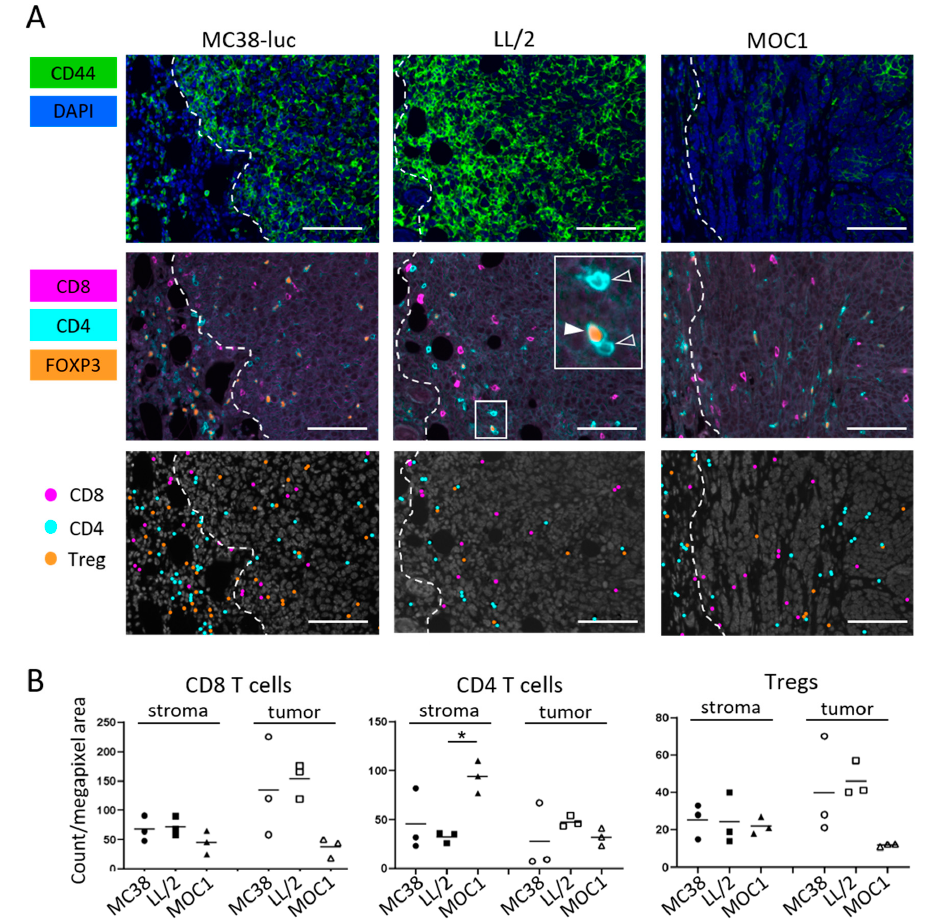
Figure 2. CD44 expression and immune cell infiltration within MC38-luc, LL / 2, and MOC1 tumors. ( A ) Multiplex immunohistochemistry (IHC) staining was performed to examine CD44 expression and distribution of T cells within MC38-luc, LL / 2, and MOC1 tumors before treatment. The top panels show CD44 expression (shown in green). Nucleus were stained with DAPI (shown in blue). White dotted lines represent tumor edges. The middle panels show expressions of CD8 (magenta), CD4 (cyan) and FOXP3 (orange). Inset shows examples of non-regulatory CD4 T cells (membrane CD4 + /nucleus FOXP3 - , open arrowhead) and Treg (membrane CD4 + /nucleus FOXP3 + , filled arrowhead). The bottom panels show cellular phenotypes based on the antigen expressions. CD8 T cell, non-regulatory CD4 T cells, Tregs are shown as dots in magenta, cyan and orange respectively. Representative images from at least three samples are shown (×200, scale bar = 100 µm). ( B ) T cell count in the tumor microenvironment. Cell number of CD8 T cells, non-regulatory CD4 T cells and Tregs in stroma and tumor tissue were counted in multiplex IHC images. Data were shown as cell count per megapixel area (n = 3; * p < 0.05; Tukey’s multiple comparison test).